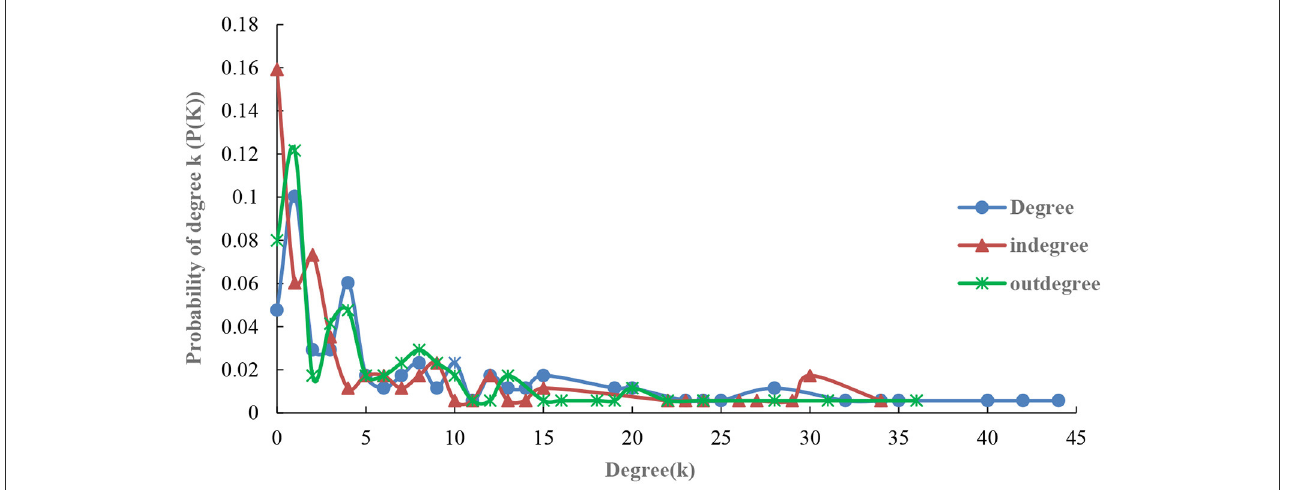
FIGURE3 Exponential probability distribution for the degree, in-degree, and out-degree of the import volumes of agricultural product in 2021.